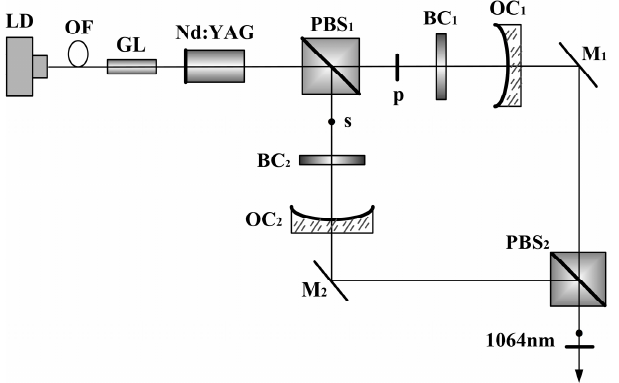
Figure 28. Schematic diagram of TCDFL based on the principle of longitudinal-mode selection by birefringent filter [36]. LD: laser diode; OF: optical fiber; GL: gradient-index lens; PBS: polarizing bean splitter; BC: birefringent crystal; OC: output coupler; M: mirror.